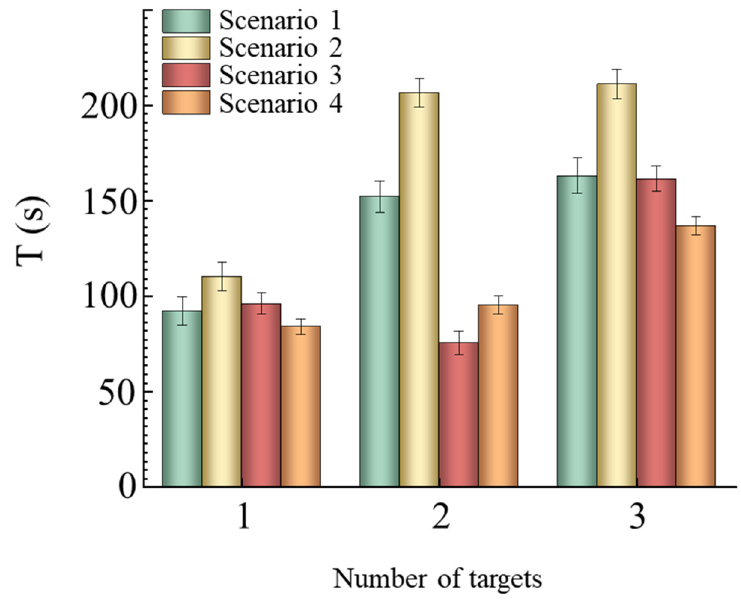
Figure 6. Mean and standard deviation of Table 1. The settings of the scenarios in this figure are the same as those in Figure 5.